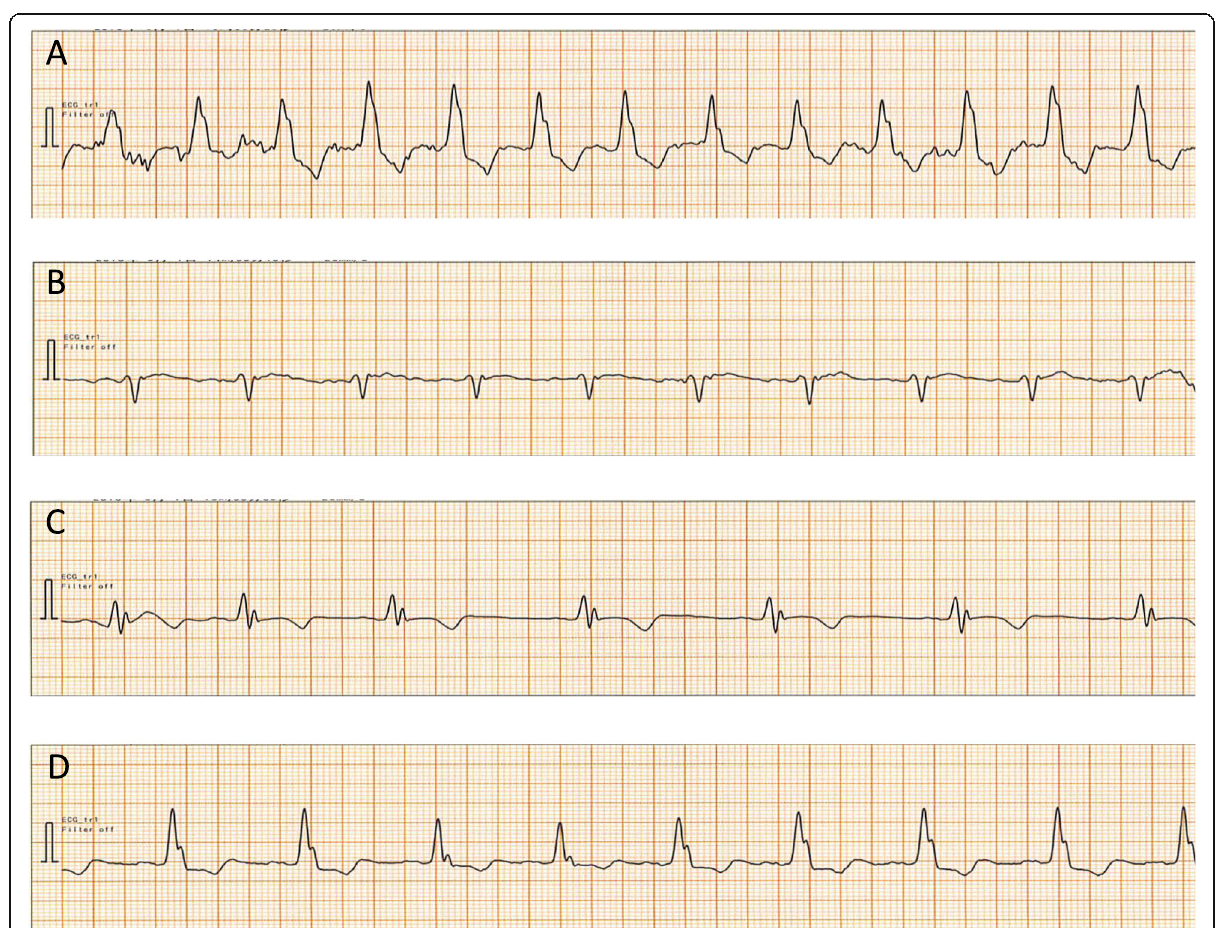
Fig. 1 Chronological changes in QRS complex morphology recorded on a patient monitor (CM5) during anesthesia. a Immediately before anesthesia induction. b 20 min after the start of anesthesia. c End of surgery. d During extubation